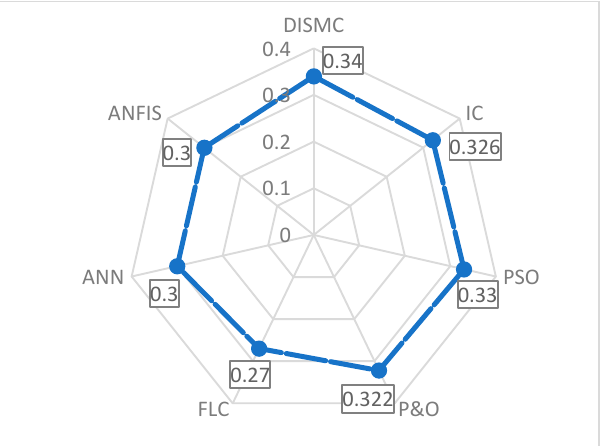
Figure 15. Relative errors of MPPTs algorithms under steady-state weather conditions: Test 1.